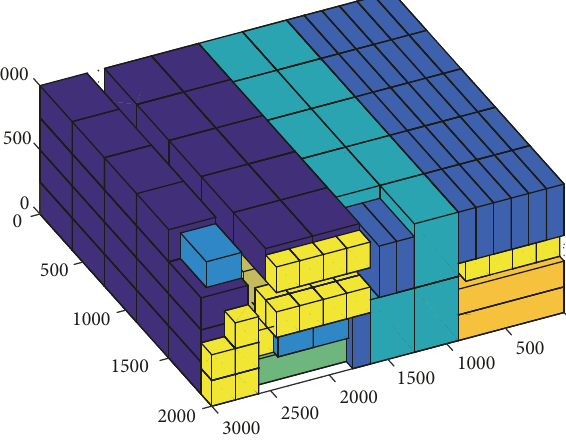
Figure 12: Packing result in